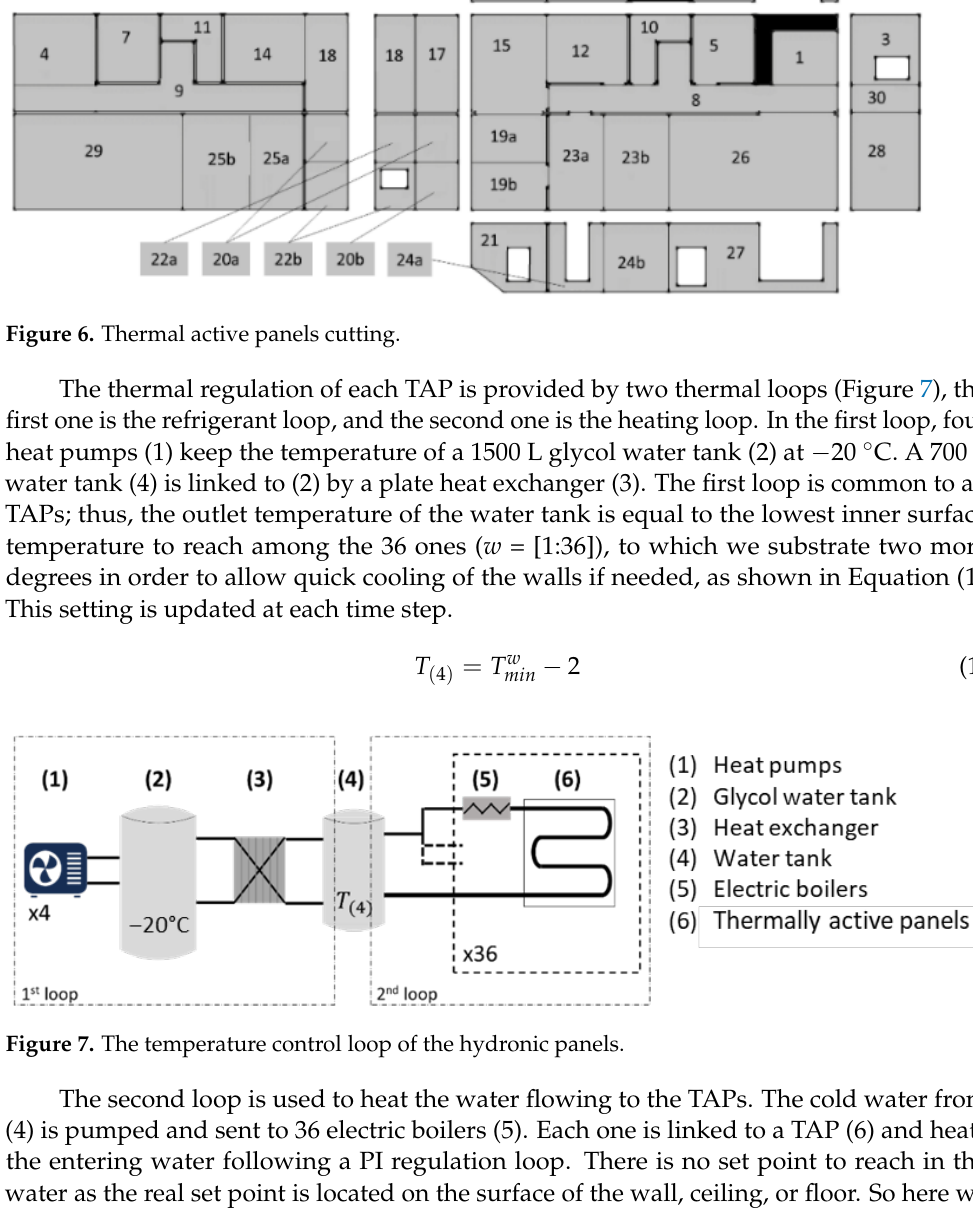
Figure 8. Electrical boilers. The target temperature for each inner surface of the envelope is calculated and used as a set point every five minutes. So between each time step, the TAPs have five minutes to reach the set point on their respective surface. The next paragraph describes the method used to calculate the set point temperature. 2.3.2. Calculation of the Inner Surface Temperature There exist quite numerous methods to estimate the thermal behaviour of a wall [18]. However, most of them either don’t consider indoor thermal perturbations or are not accurate enough when estimating the temperature distribution within the wall. As an example, the first order R-C lump method consists of converting a multi-slab wall into an equivalent one-layer wall, disabling the impact of thermal mass position on time lag [19]. A simple and accurate method to estimate the inner surface temperature of a wall is to analyse its thermal balance and solve the conduction heat equation within the wall in a